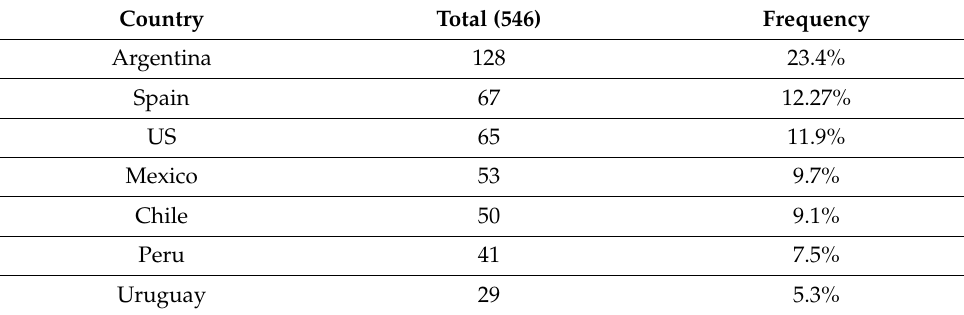
Table 6. Frequency of overall data per country.